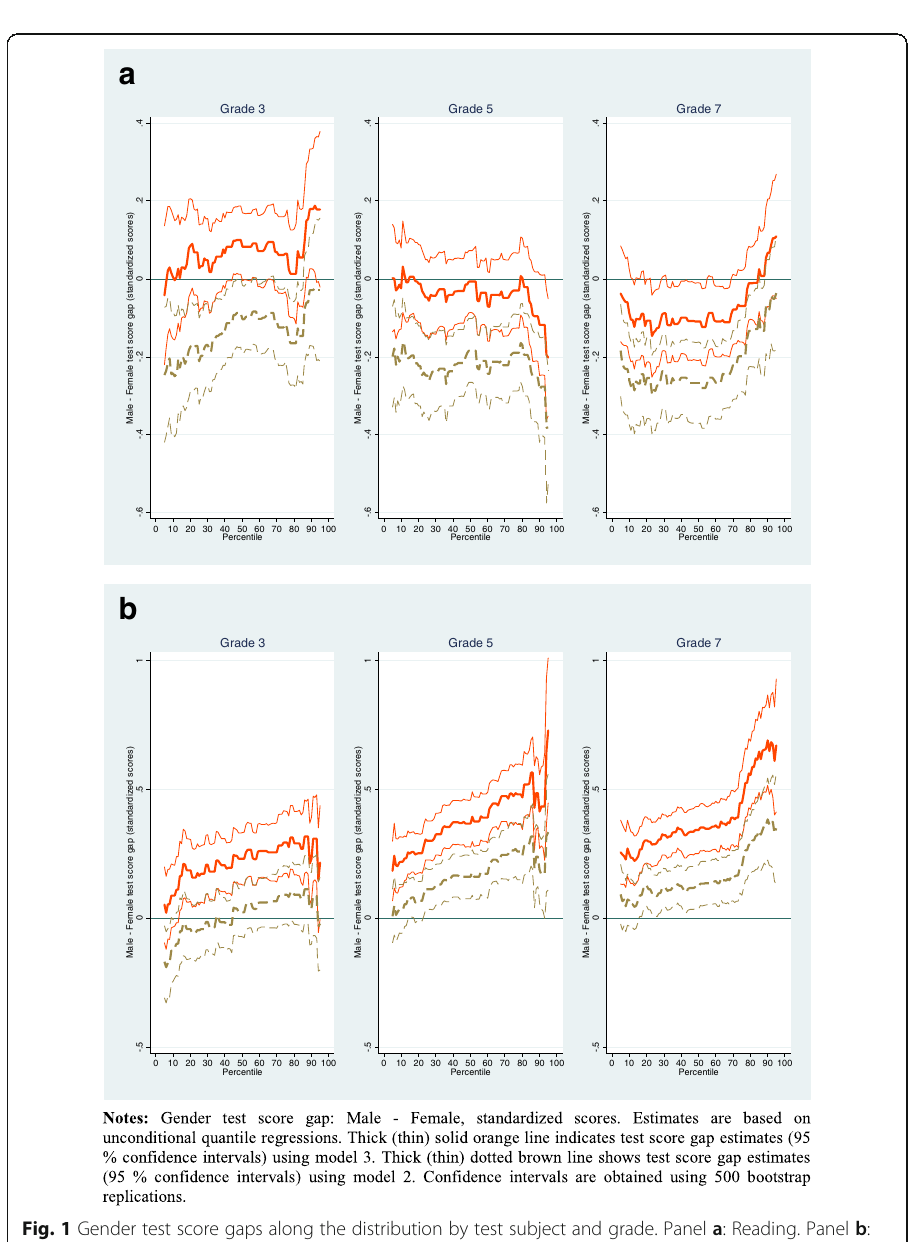
Fig. 1 Gender test score gaps along the distribution by test subject and grade. Panel a : Reading. Panel b :